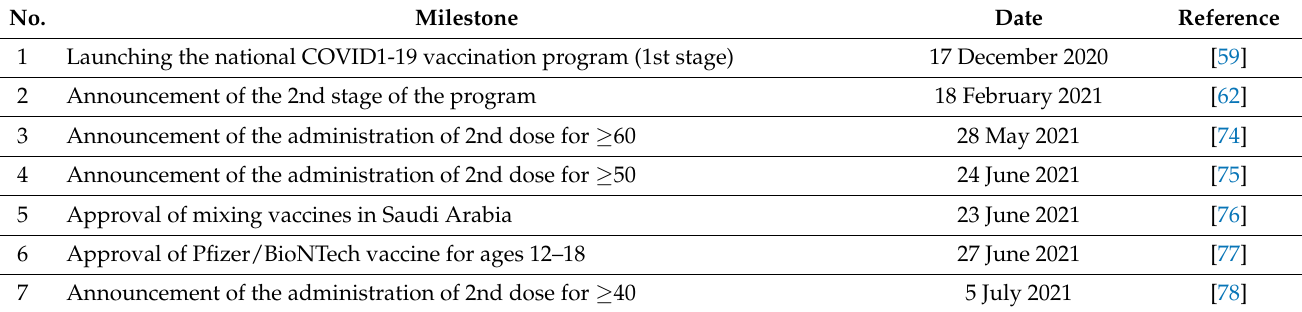
Table 1. Timeline and milestones of the national COVID-19 vaccination program in Saudi